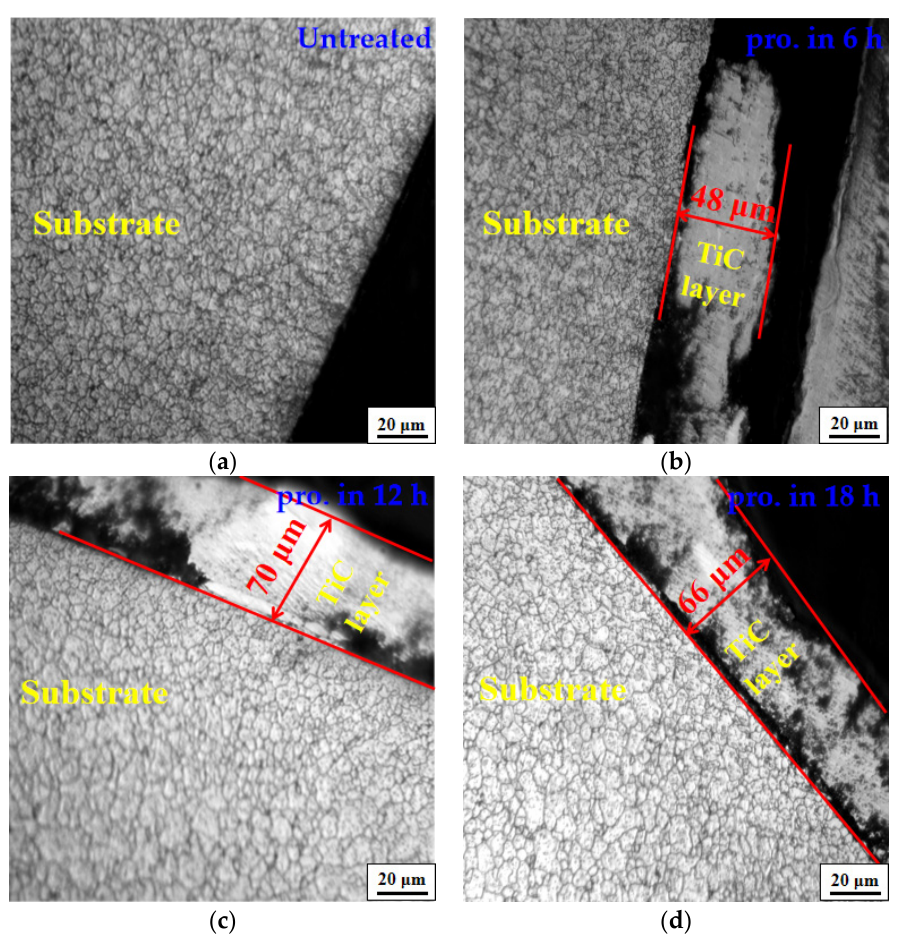
Figure 4. Optical microscopic photograph of cross section of GCr15 steel balls with different process times. ( a ) Untreated; ( b ) pro. in 6 h; ( c ) pro. in 12 h; ( d ) pro. in 18 h.